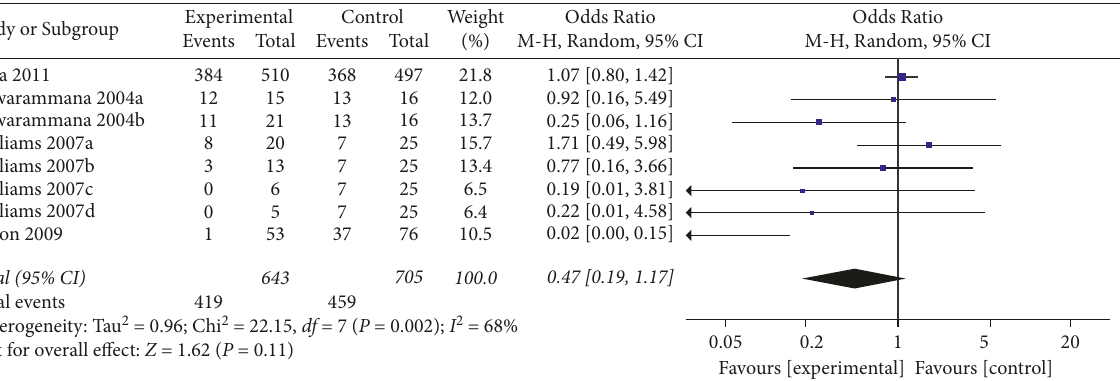
Figure 2: Forest plot of ADRs associated with antivenom use following snakebite between the prehydrocortisone with or without other drugs groups and the placebo or no premedication groups in eight comparisons from four studies.